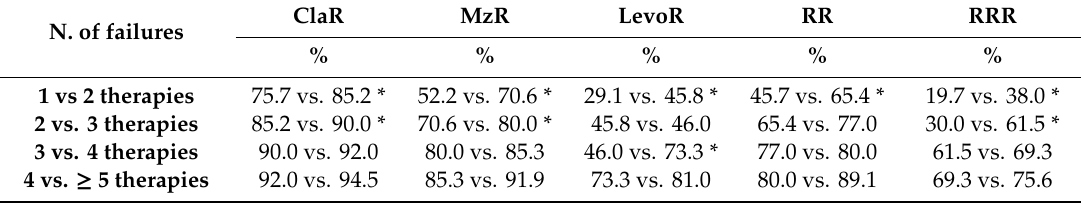
Table 3. Comparison of resistance rates based on the number of therapeutic failures. N. of failures